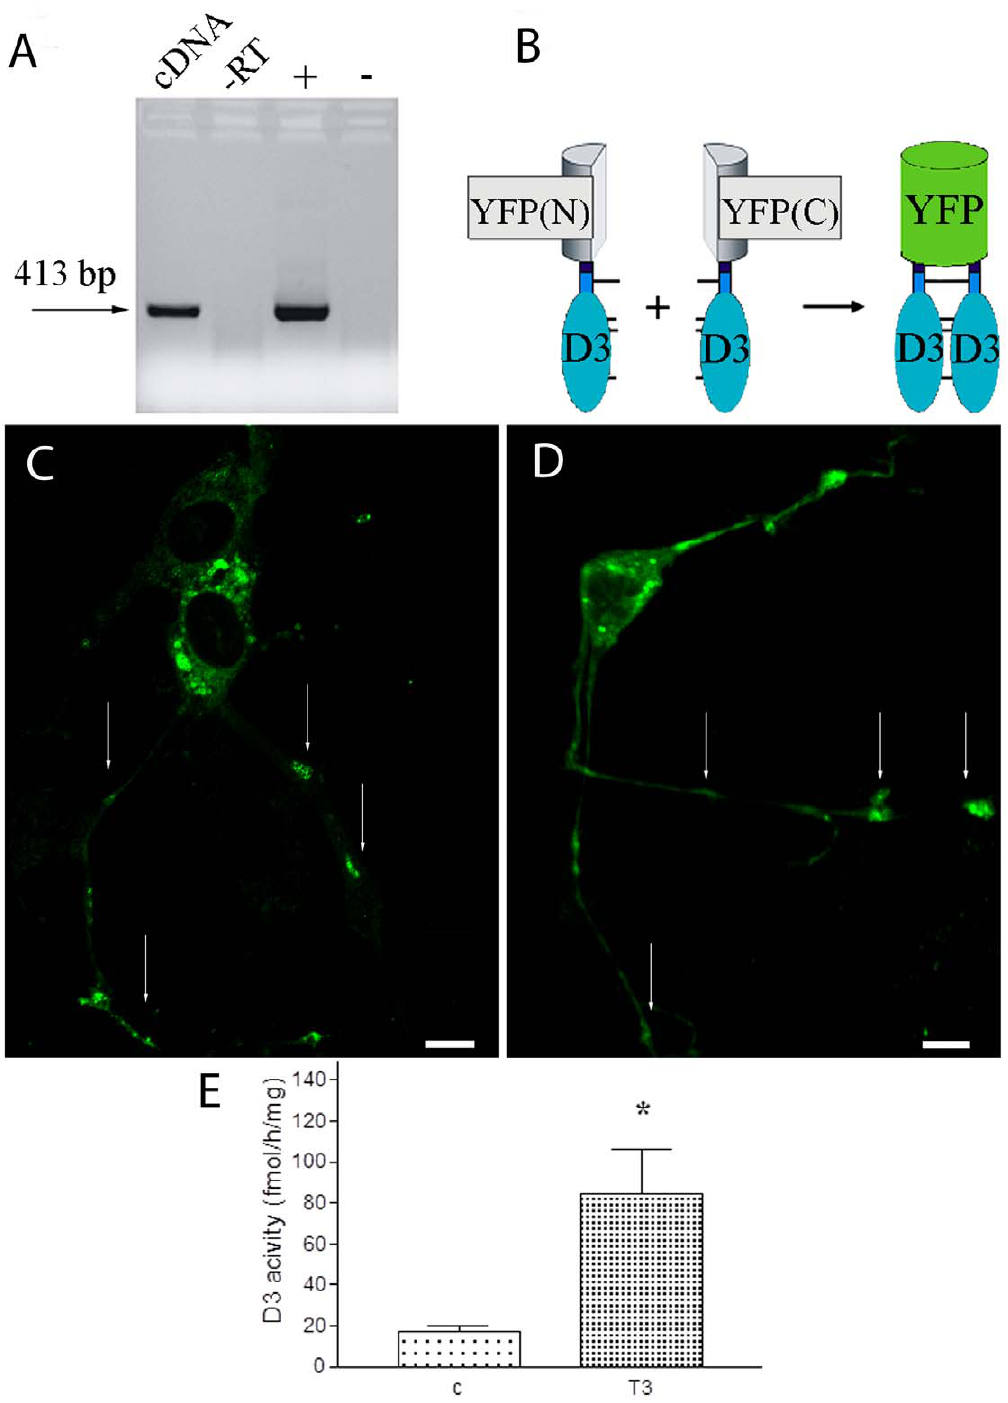
Figure 4. D3 expression in processes of mouse immortalized GT 1-7 GnRH neurons invitro. ( A ) GT 1-7 cells endogenously express D3 mRNA. –RT: minus reverse transcriptase control; + and -: positive and negative controls, respectively ( B ) Schematic illustration of Bimolecular Fluorescence Complementation used to study D3 homodimerization. YFP(N) and YFP(C) stand for YFP(1-158aa) and YFP(159–238aa), respectively. ( C ) GT 1-7 cells were transfected with a plasmid encoding the fusion protein D3-YFP(full-length). ( D ) Co-expression of YFP(1-158)-D3 and YFP-(159–238)- D3 fusion proteins results in fluorescence complementation and demonstrates D3 homodimers in the axon-like processes of GT1-7 cells. Arrows indicate D3 along the processes. Scale bars: 10 uM. ( E ). Axonal D3 activity is increased by T3-treatment in the median eminence of male Wistar rats. Mean 6 SEM (n=9) *P , 0.05 by t-test.